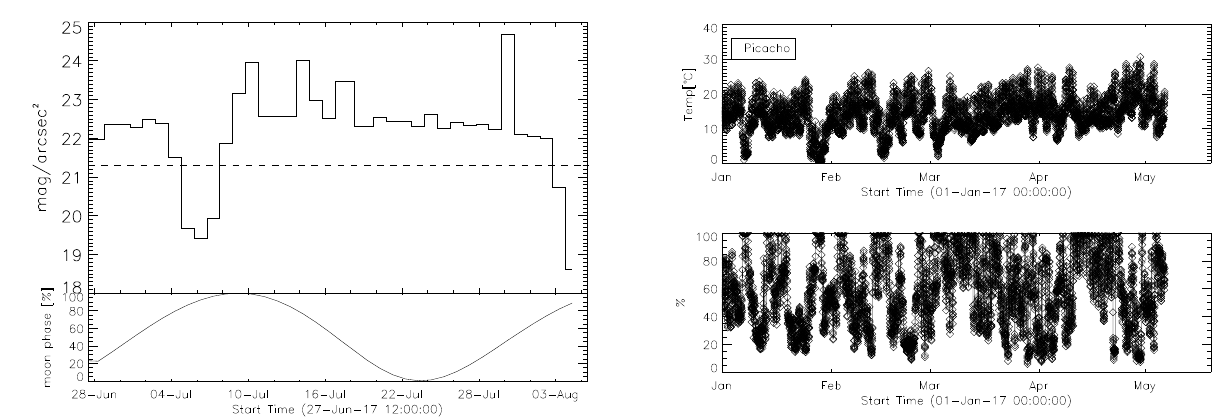
Figure 5. Top panel: Plot for Infiernillo (3,140 meters altitude) sky darkness measurements. This graph shows the maximum mag/arcsec 2 reached every night during the beginning of the sum- mer season. Bottom panel: The correspondent moon phase evolu- tion for this time.